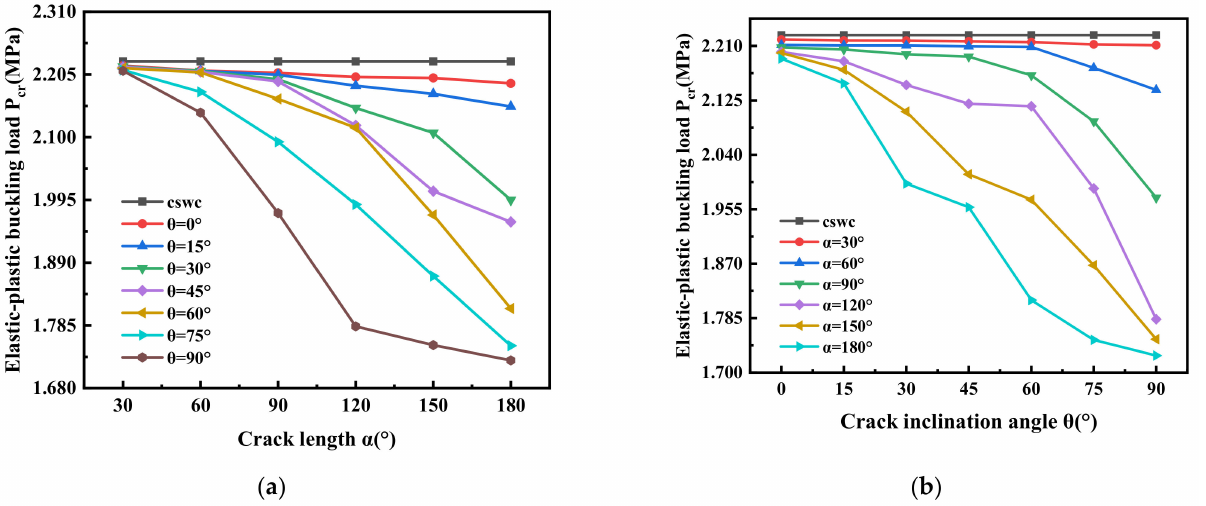
Figure 12. Relation between crack length and elastic-plastic buckling load with simple support at both ends of cylinder ( a ) Different crack lengths; ( b ) Different crack inclination